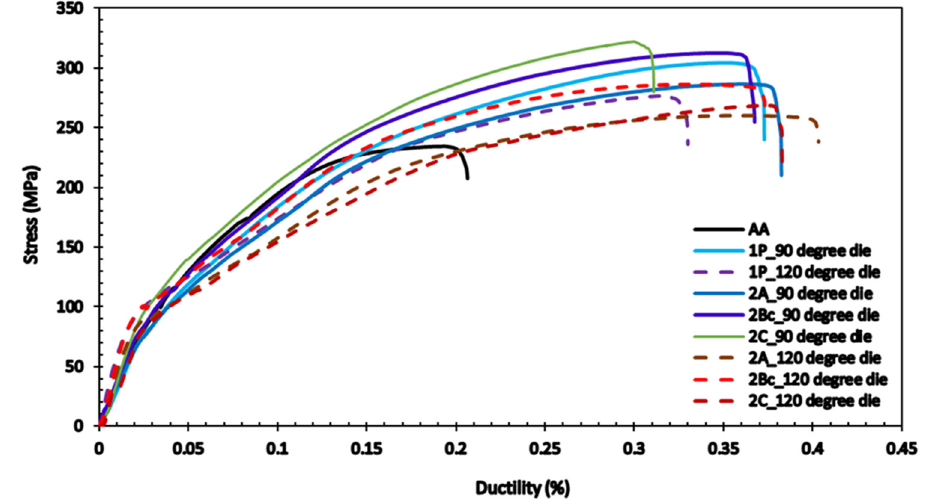
Figure 10: Tensile stress – strain curves of Mg billets processed through ECAP using the 90° - die and 120° - die via di ff erent numbers of passes and route